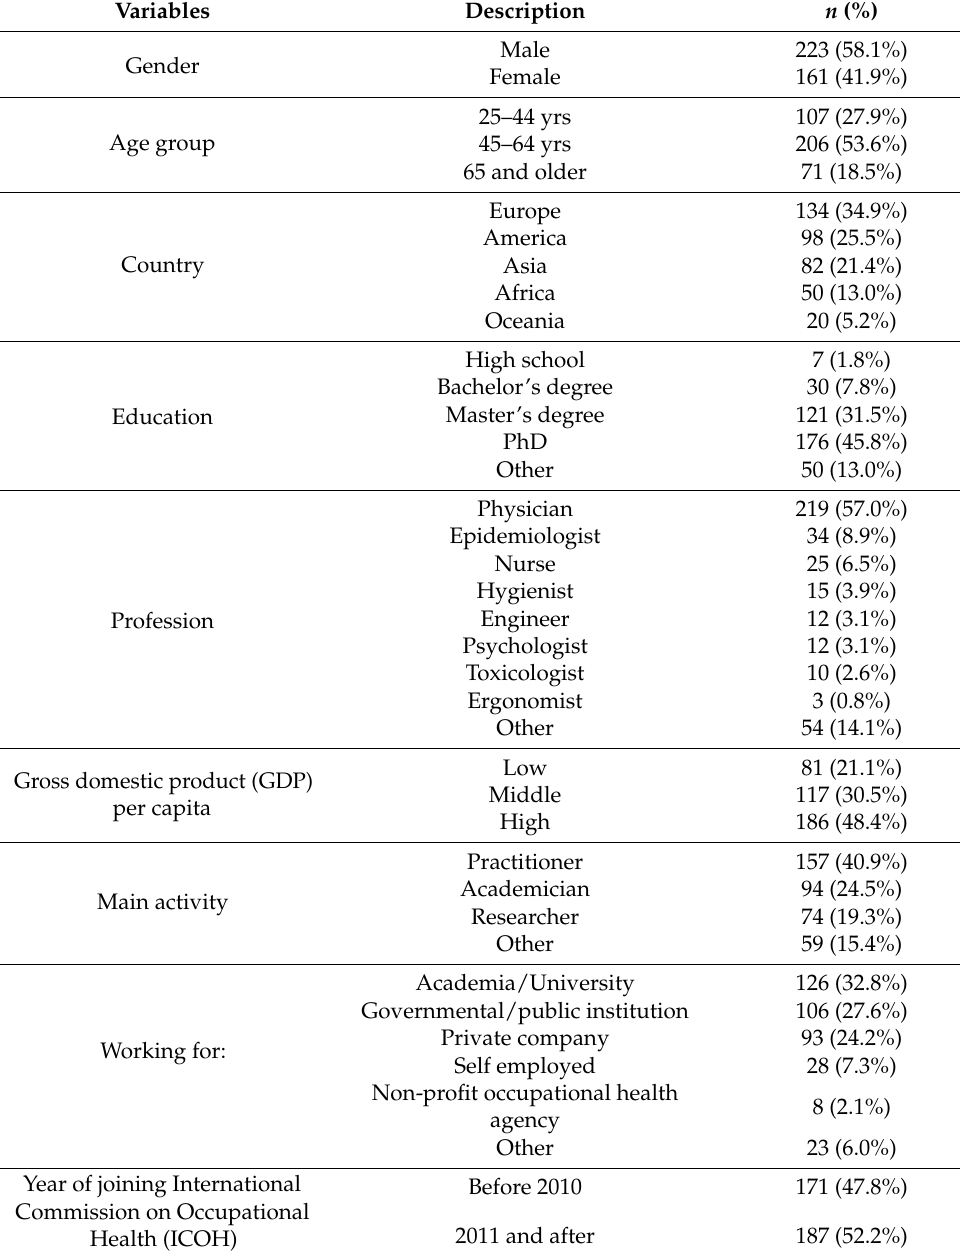
Table 1. Description of